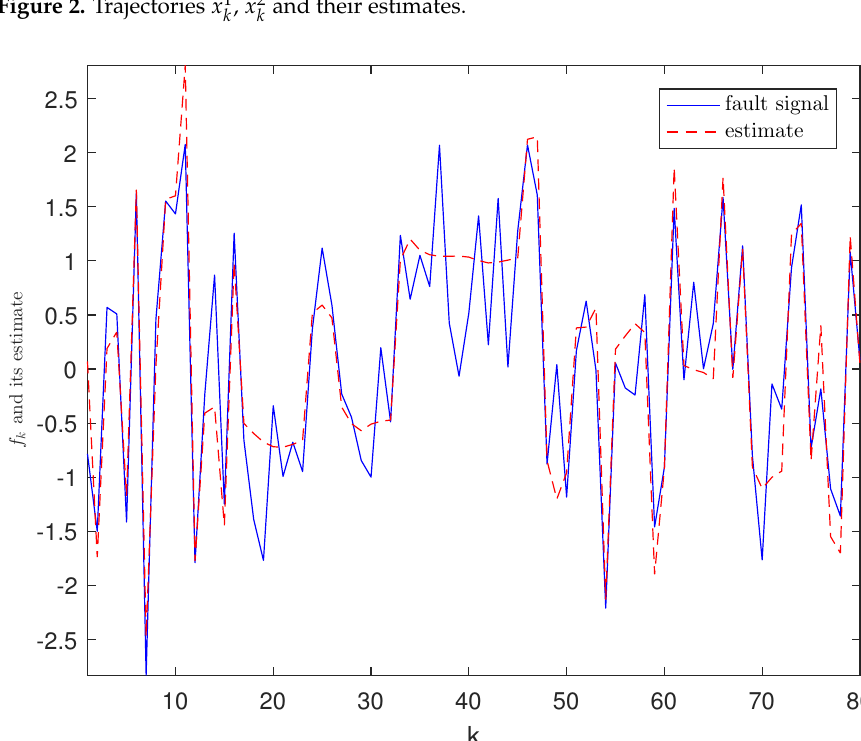
Figure 2. Trajectories x 1